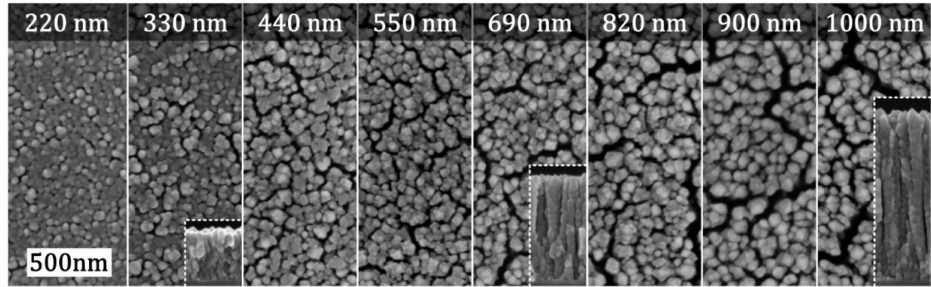
Figure 5. SEM micrographs of TiO 2 thin films with layer thicknesses ranging from 220 to 1000 nm. Considerable nanocrack networks are observed for layer thicknesses of 440 nm and above. The insets show cross-sectional micrographs. Adapted with permission from [17]. Copyright (2018)